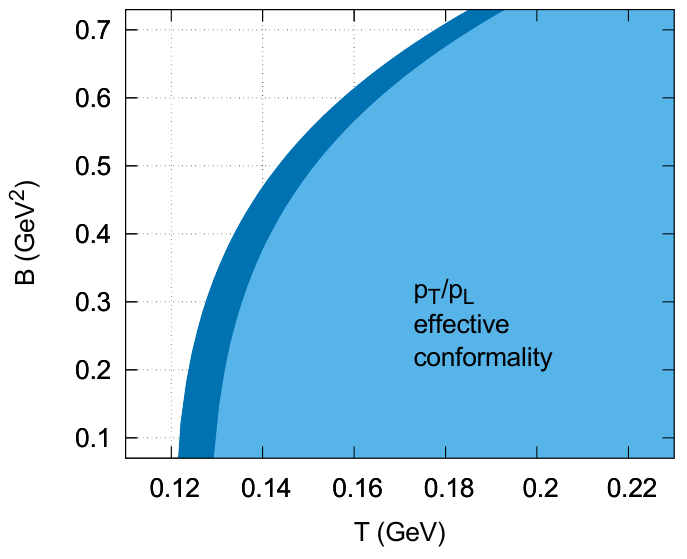
Figure 2 . Region of e(cid:11)ective conformality, in the plane of temperature and magnetic (cid:12)eld, of the QCD pressure anisotropy ratio p T =p L . Within the blue region QCD and N = 4 SYM, appropriately compared, give identical values for this ratio to within the error estimates of the lattice data. The dark blue band indicates the uncertainty in the border of this region arising from lattice